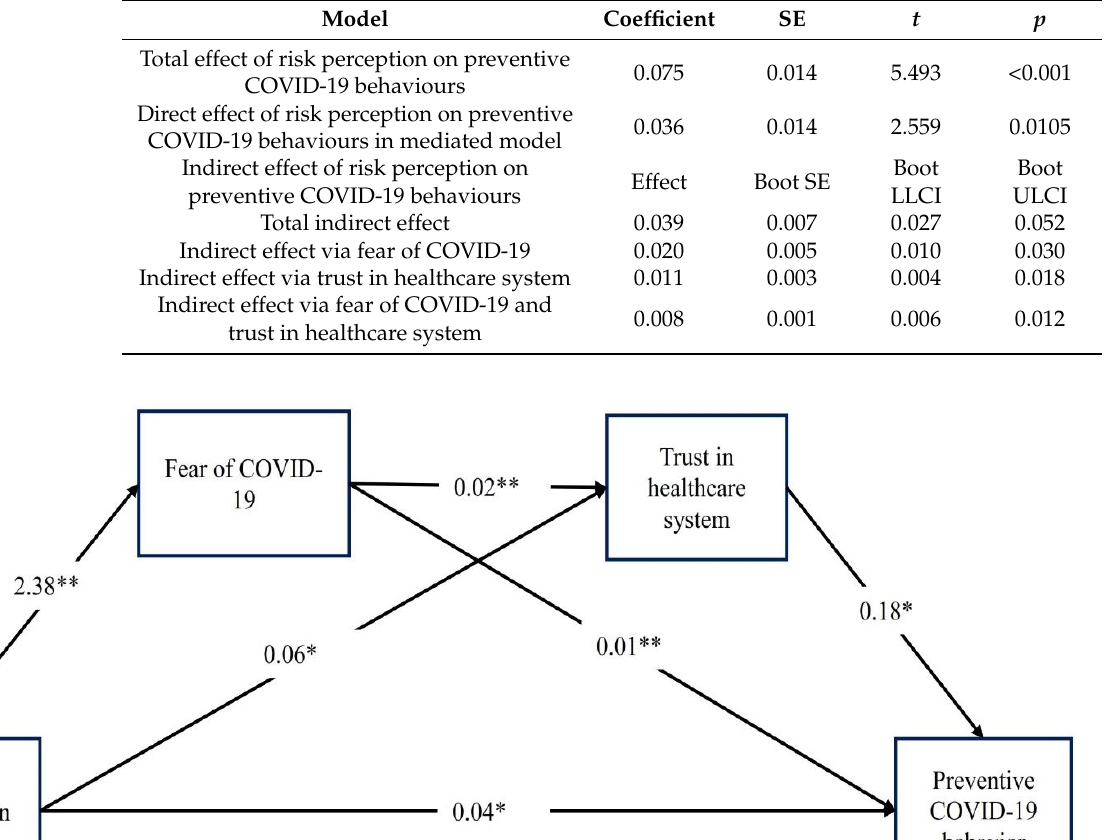
Table 4. Models of the effect of risk perception on adherence to preventive COVID-19 behaviours with mediators of fear of COVID-19 and trust in healthcare system.